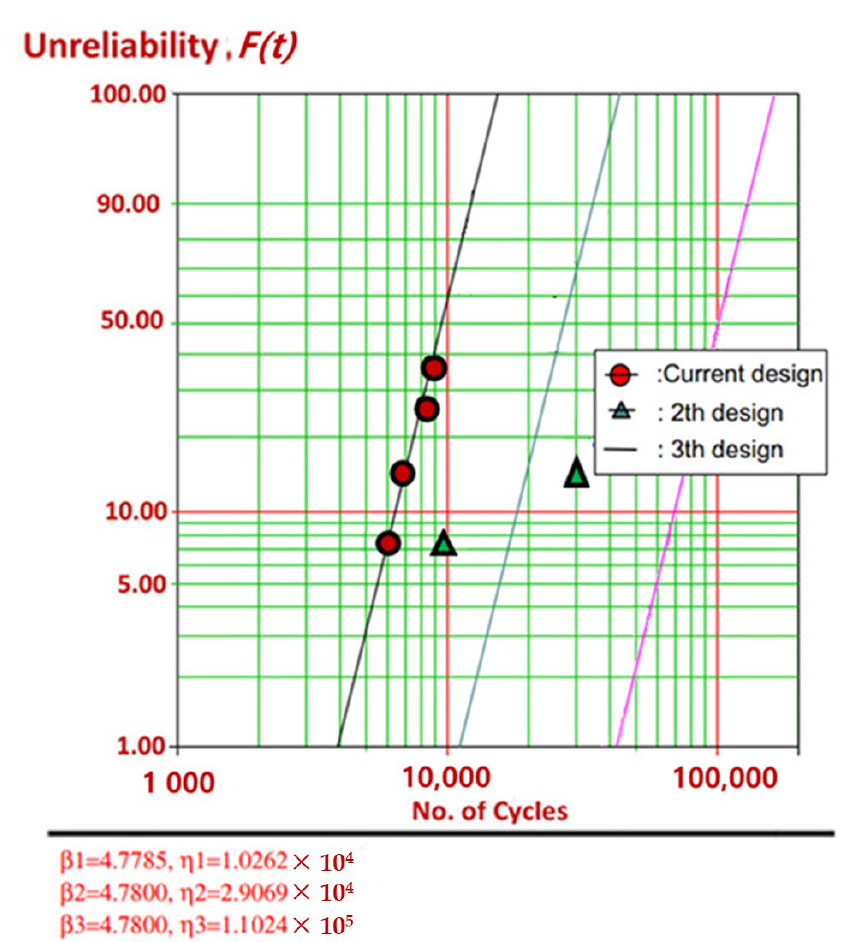
Figure 15. Consequence of parametric ALT on Weibull plot.